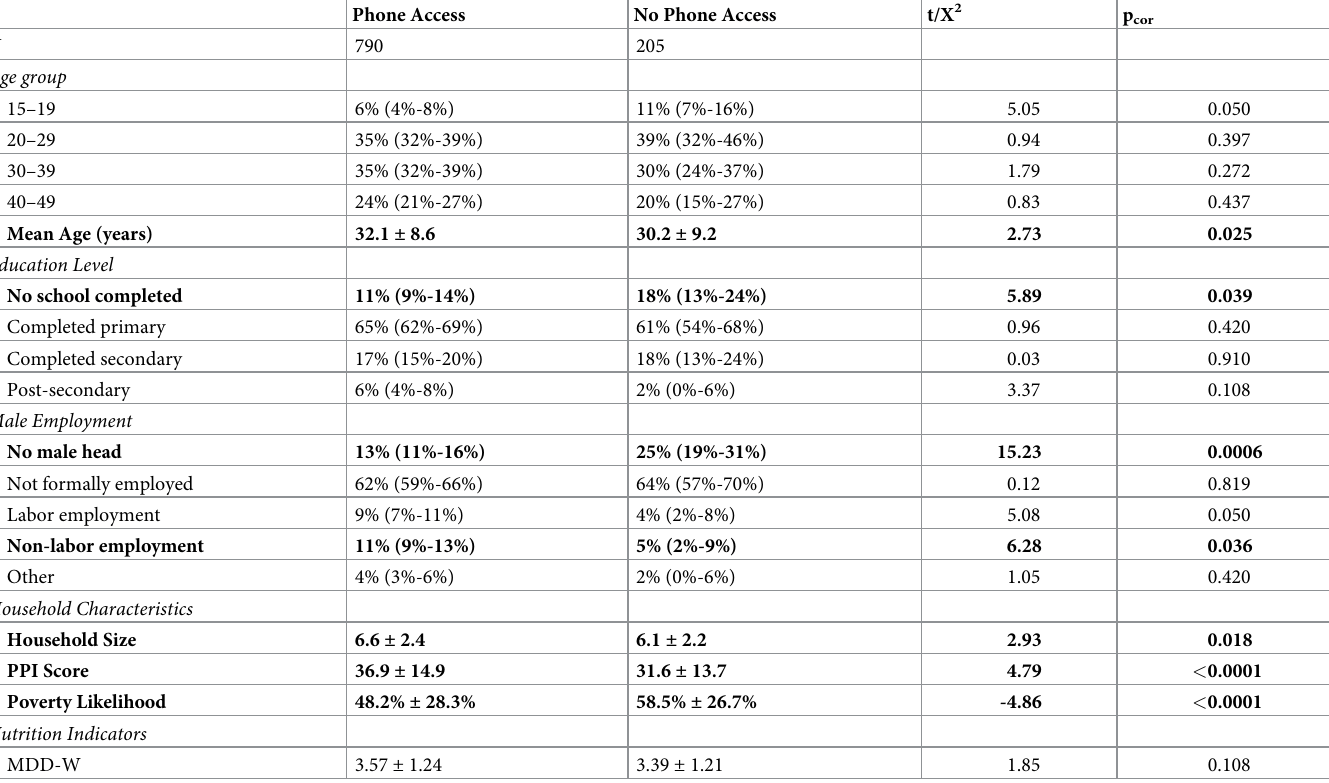
Table 6. Differences between target women with and without access to a mobile